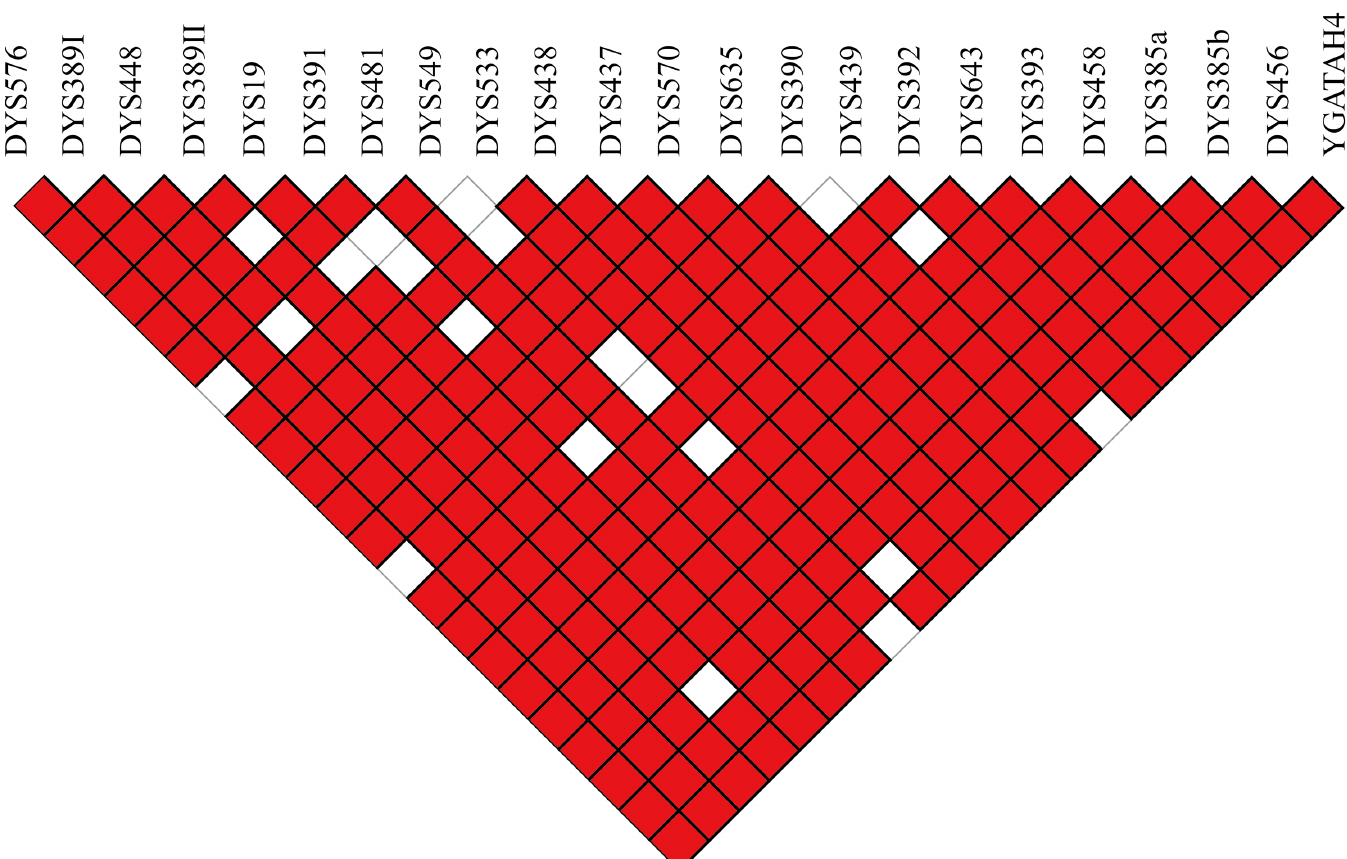
Fig 2. The LD analysis among 23 Y-STR loci. The red area encircledby thick black line represented significantly strong linkagerelationship.